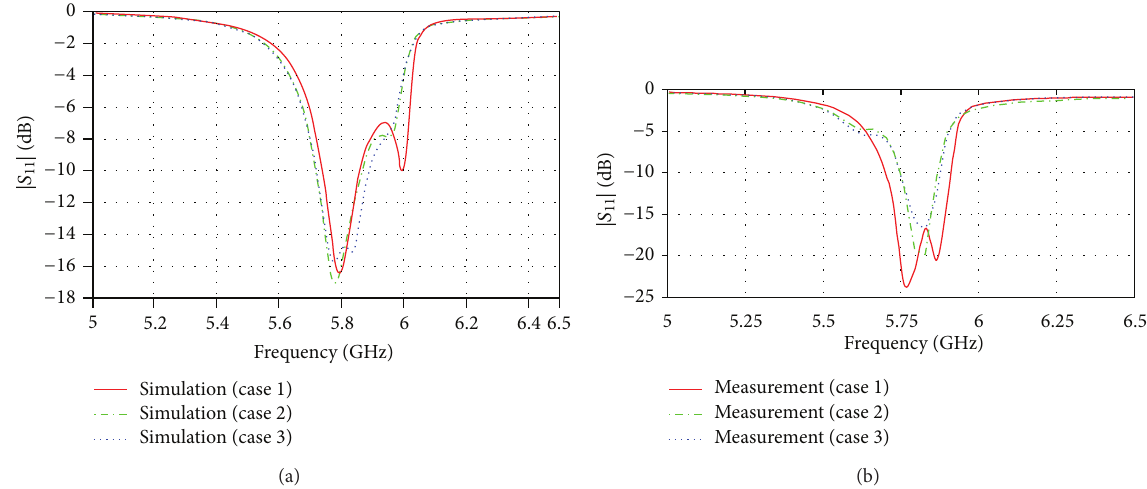
Figure 24: (a) Reflection coefficients of beam steering reference antenna in simulation. (b) Reflection coefficients of beam steering reference antenna in measurement.